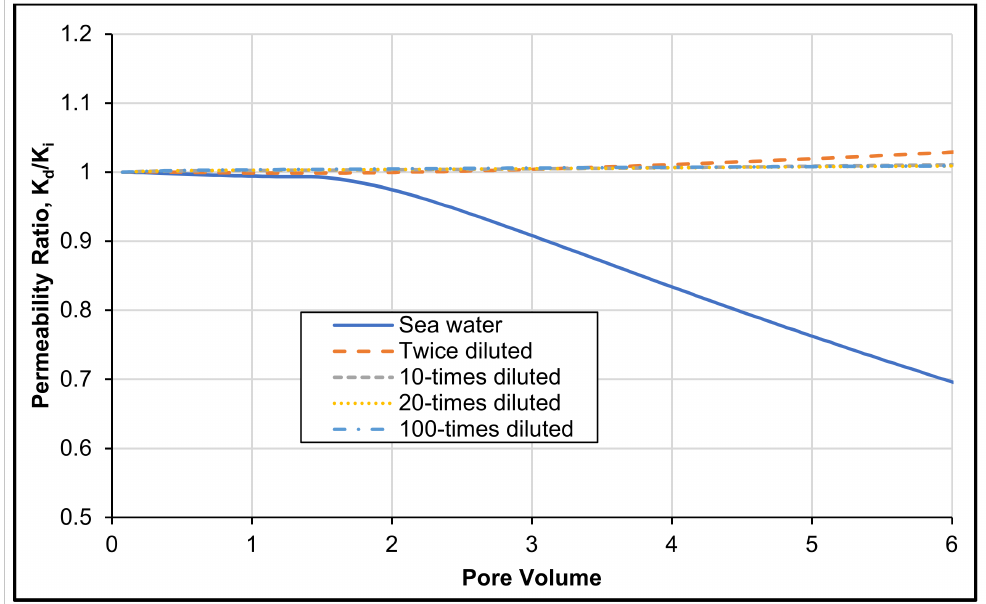
Figure 10. Effect of water dilution on formation permeability ratio for the first gridblock at 6 PVs with formation and injected water temperatures fixed at 200 ◦ C and 100 ◦ C,